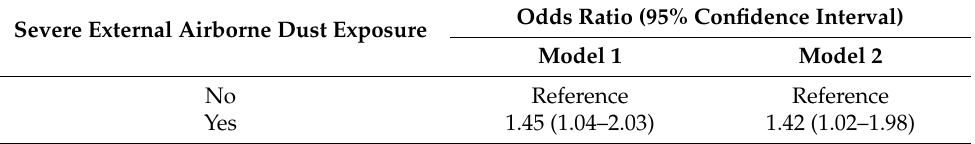
(Model 1: age, sex, and household income level; Model 2: all statuses from Table 3). All models revealed that the risk of dementia significantly increased with external airborne agents’ exposure. The odds ratios with 95% CI of Crude model and Models 1 and 2 were 1.45 (1.04–2.03) and 1.42 (1.02–1.98), respectively. Table 4. Logistic regression results of positive dementia screening test according to occupational dust exposure